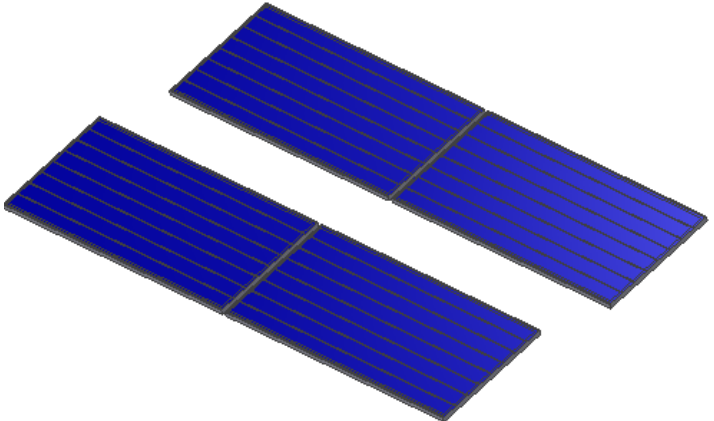
Figure 4. Case I — 3D representation of a single-row landscape configuration. Figure 4. Case I—3D representation of a single-row landscape configuration.